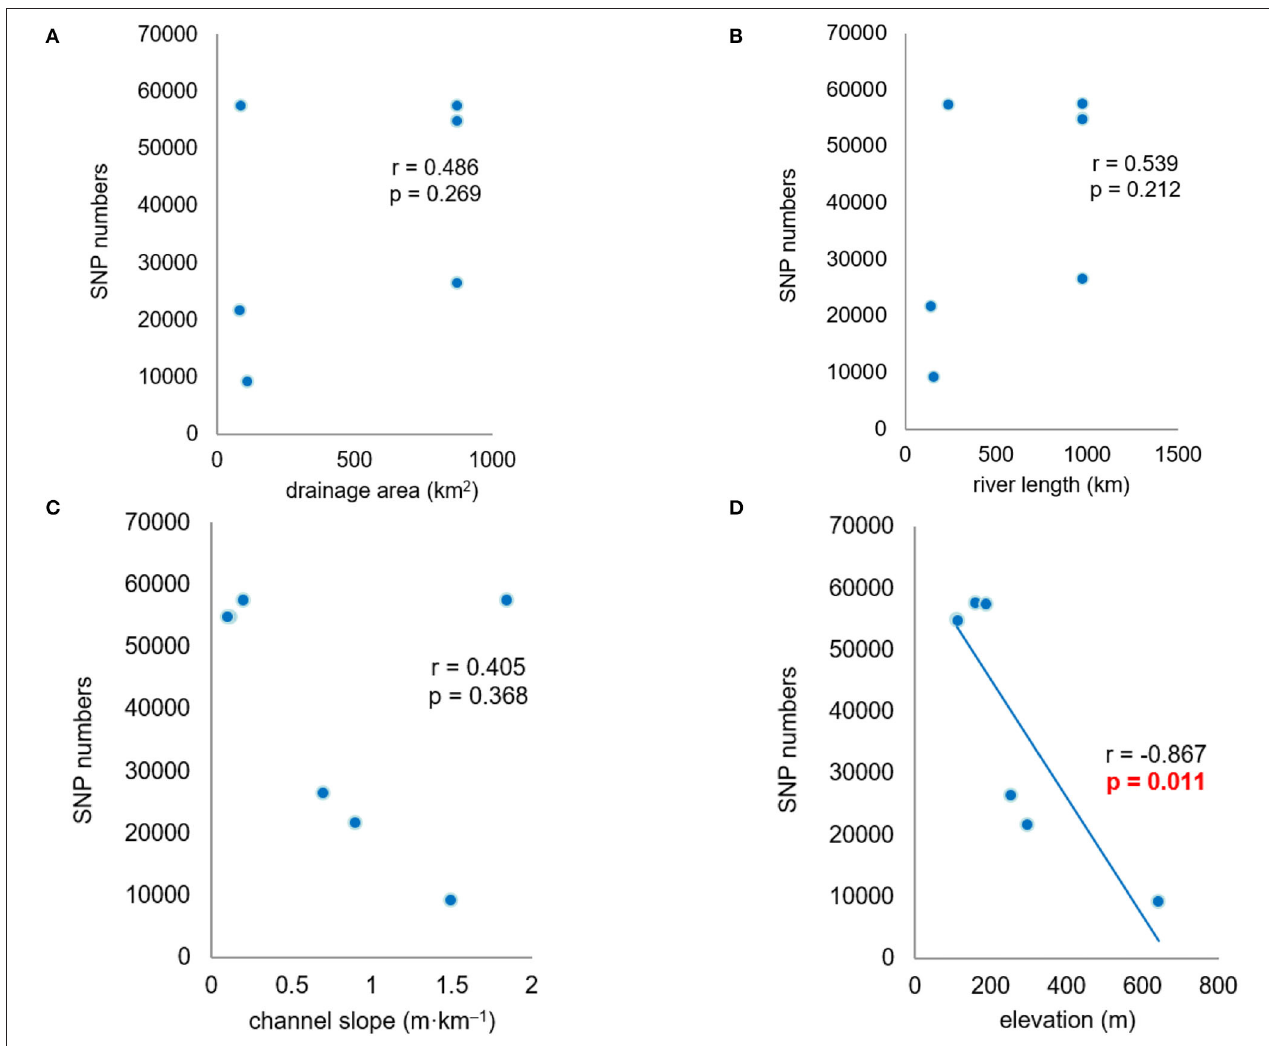
FIGURE 4 | Correlation analysis between the single nucleotide polymorphism (SNP) numbers and environmental factors. (A–D) r is correlation coefficient, p value is used to determine the result of hypothesis testing.